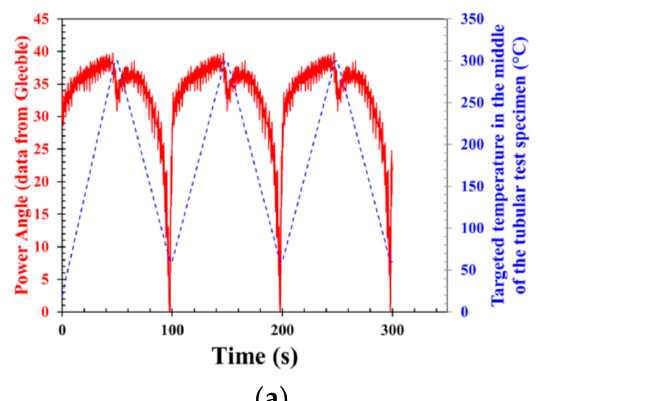
Figure A4. ( a ) Surfaces for current arrival, ( b ) Surfaces for mass, ( c ) "strong" electrical contact sur- faces, d) "weak" electrical contact surfaces.